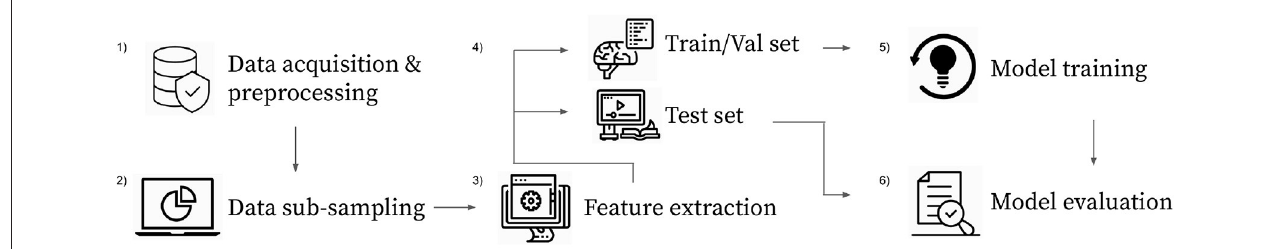
FIGURE 1 | Single experiment pipeline. (1) Read raw data, remove baseline recording and pre-process. (2) Sample (60 × 128) / w EEG windows with size w for each video. (3) Extract features from all windows individually and normalize. (4) Split dataset into train, validation and testing( tr s / 100/ s − tr s − 100). (5) Train chosen model using train and validation datasets. (6) Evaluate trained model on the testing dataset. Record experiment parameters, training metrics, and testing